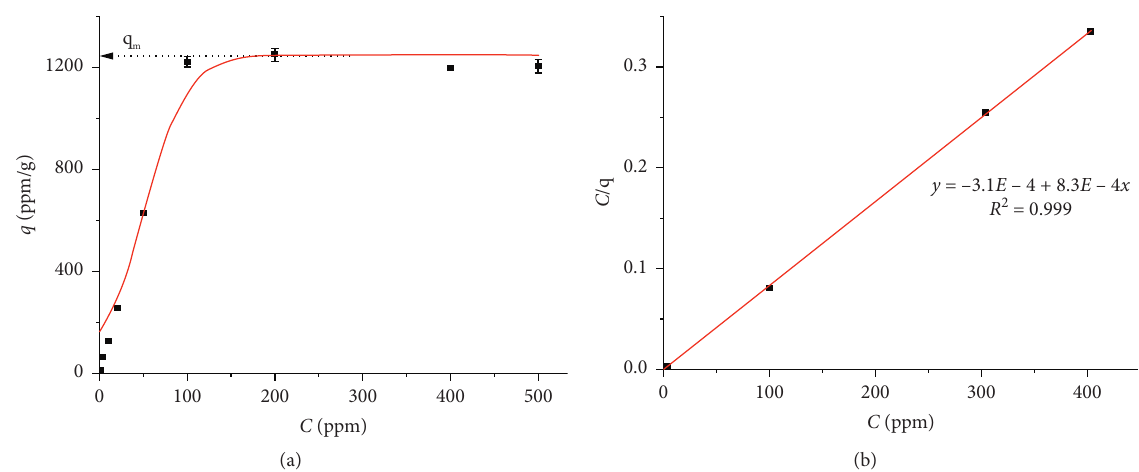
Figure 18: (a) Optimal adsorbed amount ( q m ) and (b) the Langmuir adsorption isotherm of Cr(VI) by Fe 3 O 4 @SiO 2 @ LEuH@PW 10 nanocomposite at 25 ° C and pH � 6.